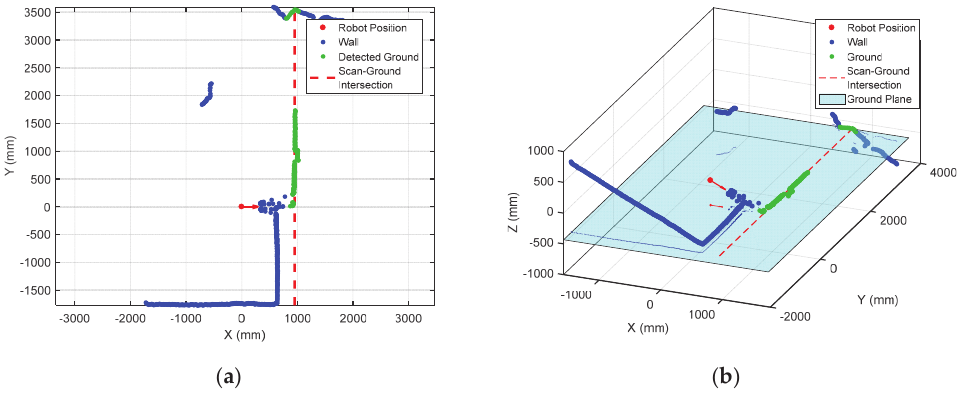
Figure 9. Experiment in front of a stairs going up: ( a ) raw scan data, ( b ) 3D representation.